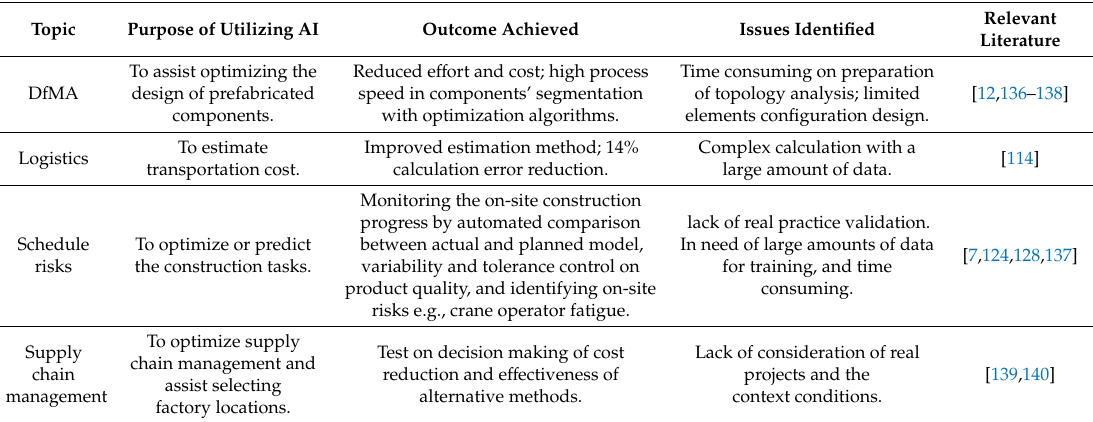
Table 14. Research topics, purpose of artificial intelligence (AI) adoption, and outcomes achieved in previous